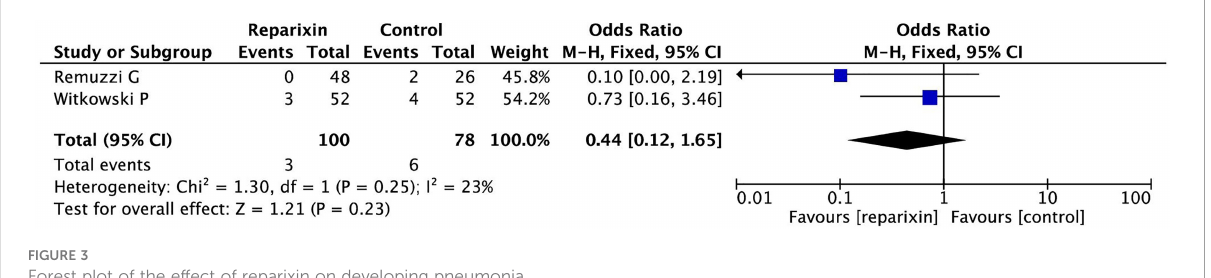
FIGURE 3 Forest plot of the effect of reparixin on developing